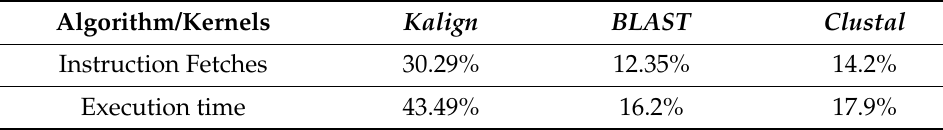
Table 2. Acceleration